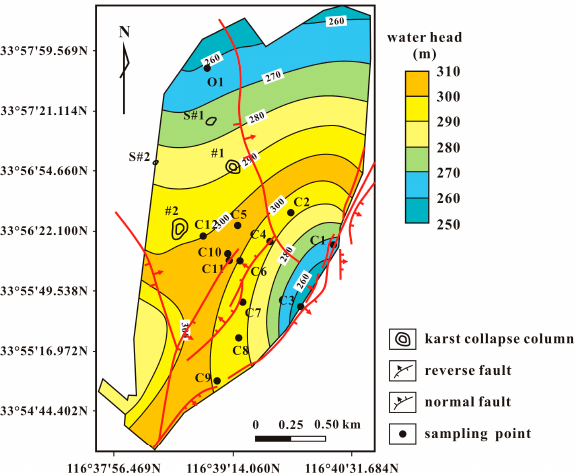
Figure 2. Groundwater flow field of Carboniferous Taiyuan limestone karst-fissure aquifer systems in the study area. There are three main flow directions: northeast, southeast, and southwest, in this groundwater flow